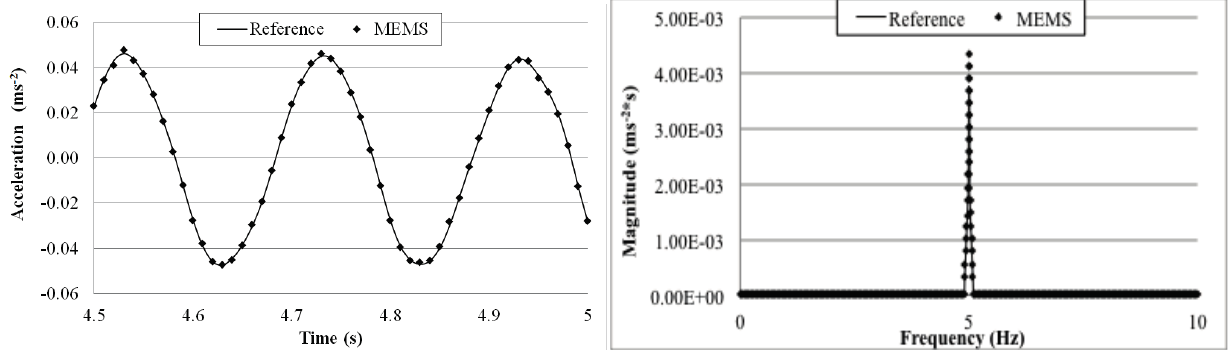
Figure 15. Comparison of measurements by the two Sensors in time and frequency domains (5 Hz sinusoidal